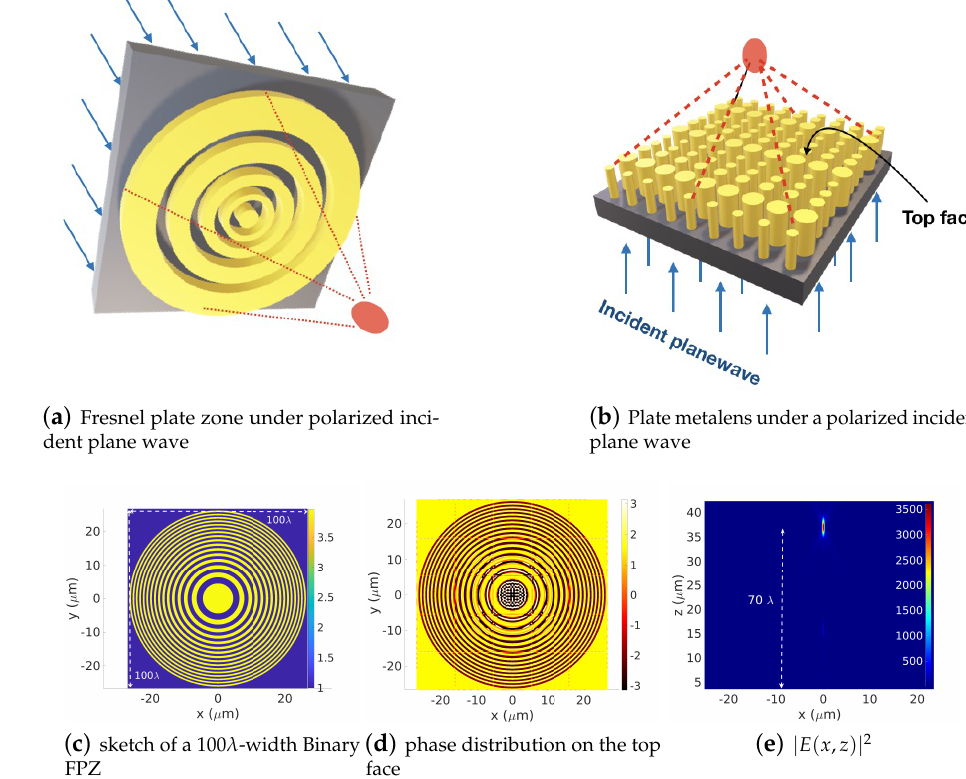
Figure 8. A forward simulation of a 100 λ -width FPZ using the DDSM. The computation domain is subdivided into 5 × 5 sub-domains Ω ij . ( c ) presents the sketch of the diffractive Fresnel lens, ( d ) shows the phase distribution on the top face of the lens and ( e ) displays the transmitted field. Numerical parameters: λ = 0.532 µ m, z s = 70 λ , n = 31 zones (15 rings), D x = D y = 100 λ h = 400 nm, refractive index of the lens material 1.99, refractive index of the substrate 1.45, m x = m y = 12, ( M x = M y = 62). Table 1. Panel of the computation times for the simulation of the FPZ near field on each sub-cell using the aperiodic Fourier modal method (AFMM). Simulation is performed on a classical computer DELL PRECISION 3640 with a processor intel CORE i9 (3.10 Ghz). The whole [ − 0.5 D x ,0.5 D x ] × [ − 0.5 D y ,0.5 D y ] surface is strongly inter-meshed 2 12 × 2 12 nodes have been used both for the highly pixelated profile the FPZ lens surface and also for the computation nodes of the near field. m x = m